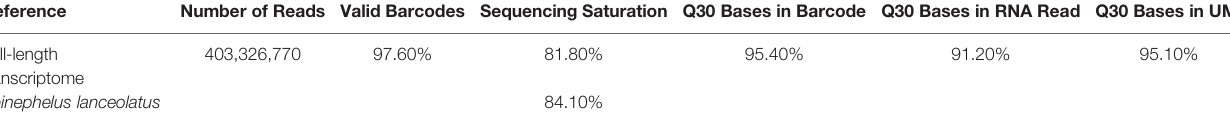
TABLE 1 | Sequencing saturation comparison between different